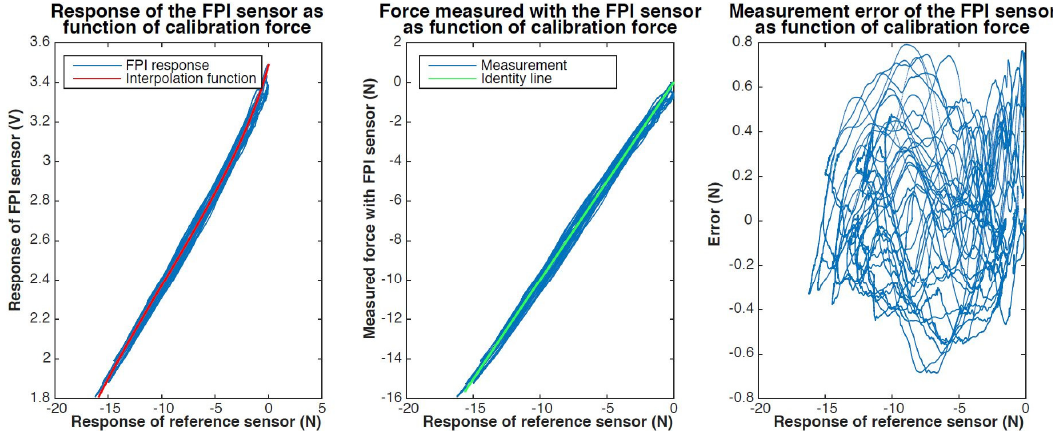
Figure 15. Results of dynamic calibration of a proof-of-concept of the thin-film concept at room temperature. The response of the FPI as function of the calibration force, together with third order polynomial interpolation function, is shown in the figure on the left. The figure in the middle shows the force measured with the proof-of-concept, calculated using the interpolation function, as function of the calibration force and the indentity line ( y = x ) as a reference. The measurement error of the proof-of-concept as function of the calibration force is shown on the